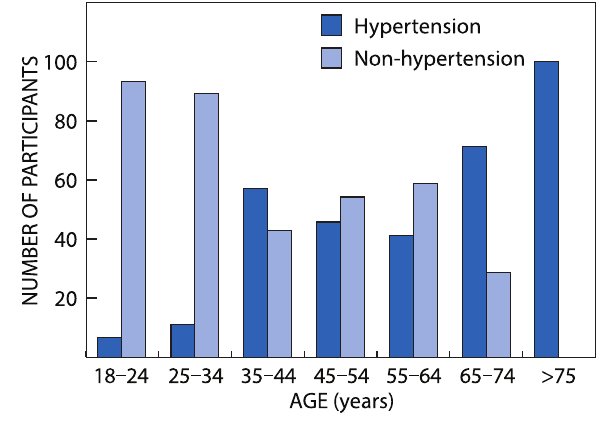
Figure 1: Bar chart demonstrating the prevalence of hypertension by age group in Kang participants, Botswana, in